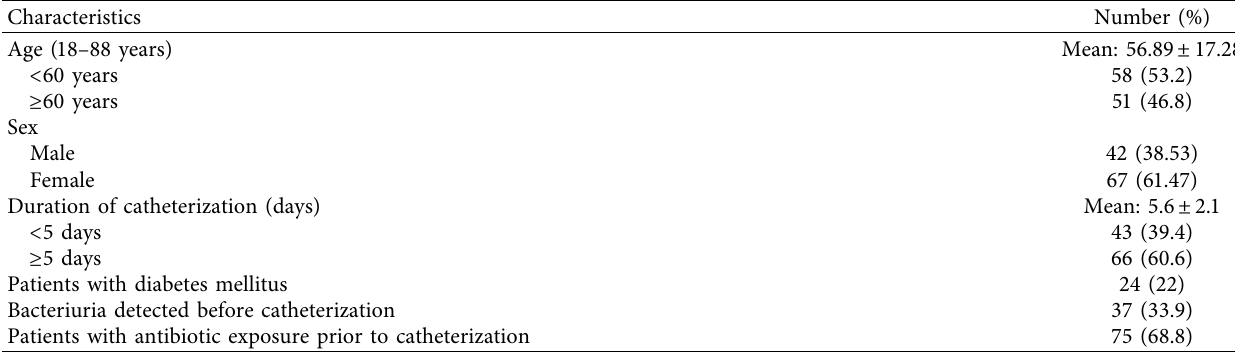
Figure 2: Distribution of isolates between the urine ( n � 43) and catheter ( n � 107) cultures according to the CRA test. E. coli was the dominant microbial with a positive CRA test in the urine and catheter culture. Table 3: Baseline characteristics of 109 patient respondents.